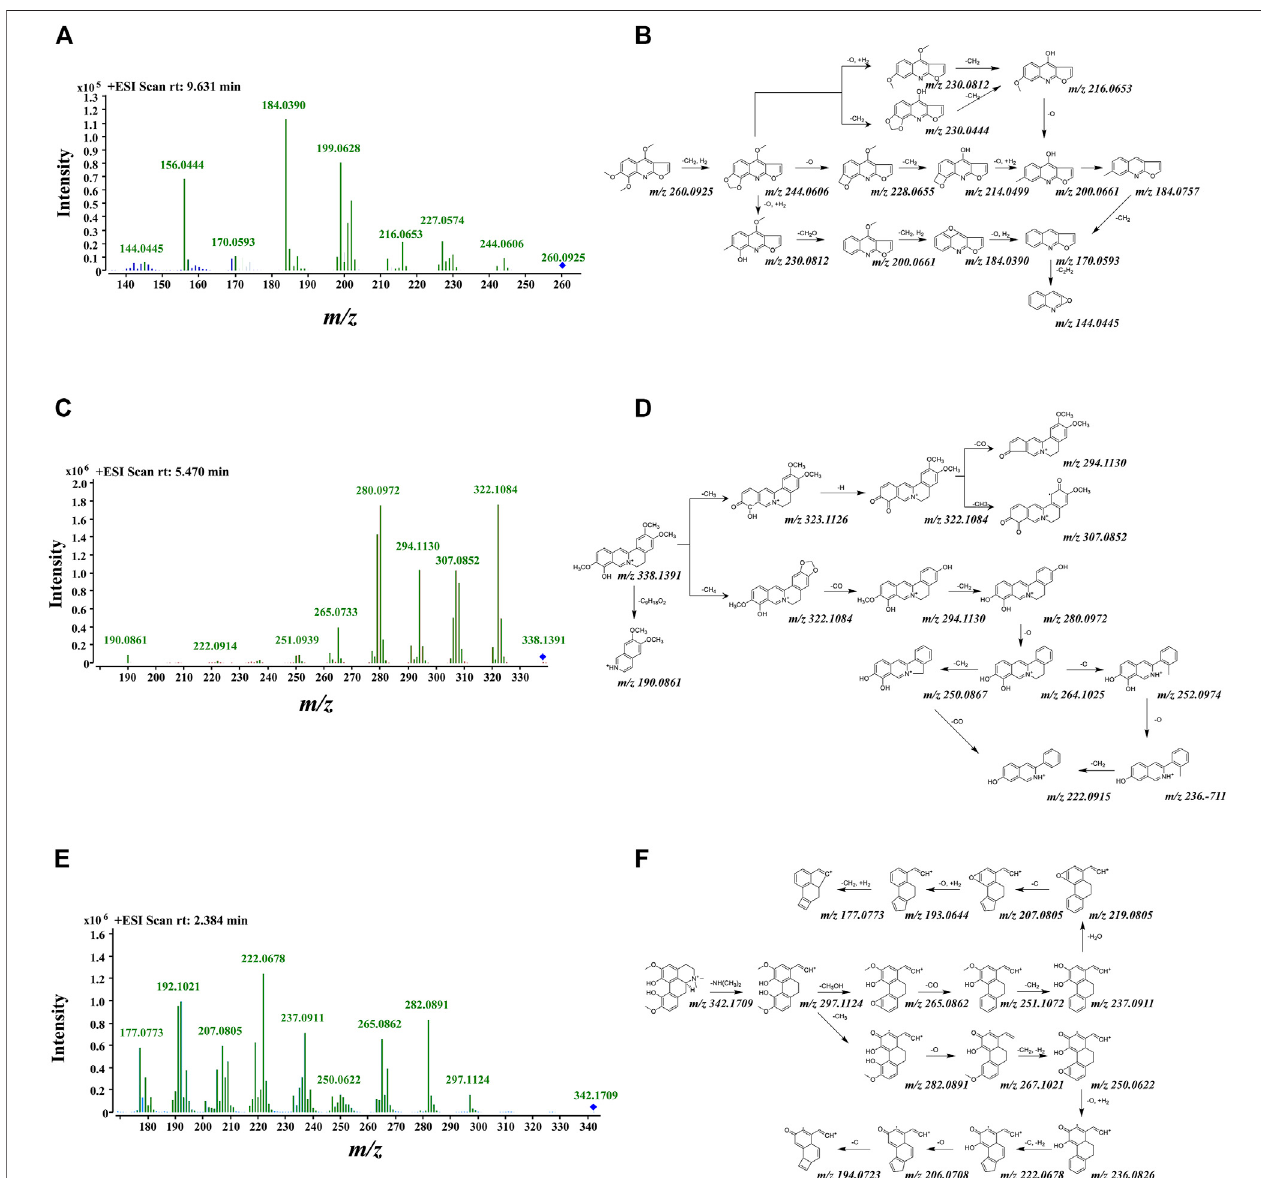
FIGURE 3 | Tentative fragmentation pathway and mass spectrogram of several typical alkaloids in ZN. (A,B) Skimmianine; (C,D) jatrorrhizine; (E,F) magno fl orine.